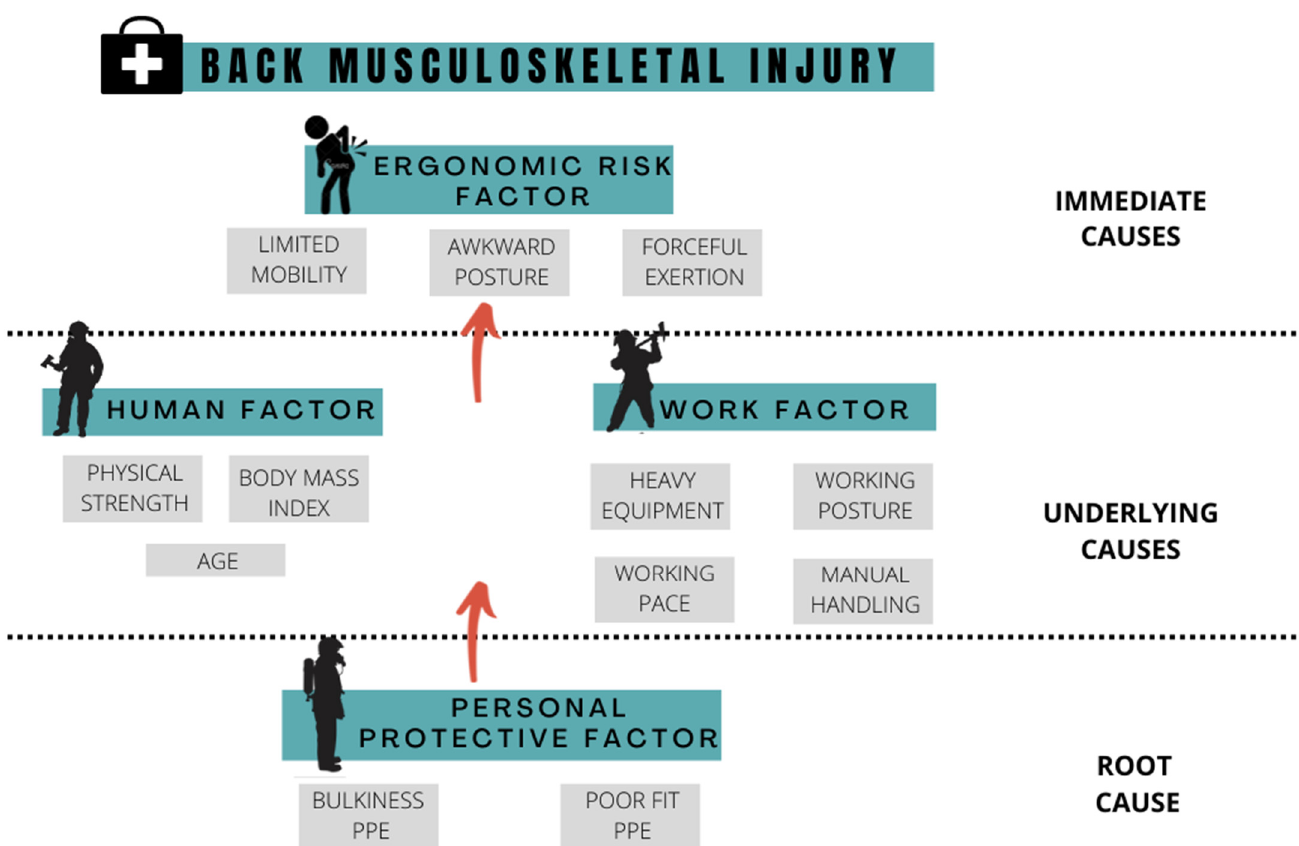
Figure 10. The framework of causes for back musculoskeletal injury of FFs.